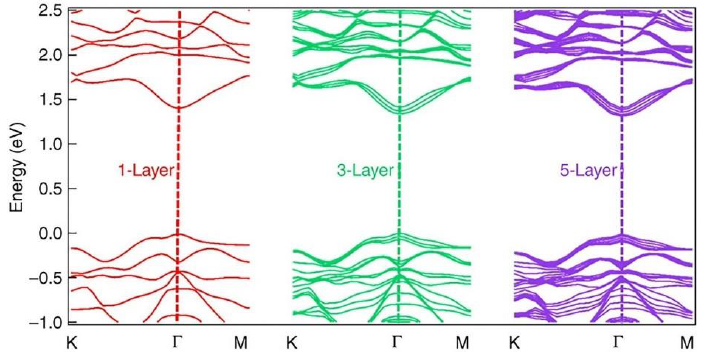
Figure 4. Ab initio calculated electronic band structure of monolayer, trilayer and five-layer ReS 2 indicating band gaps of 1.44, 1.4 and 1.35 eV, respectively. Reprinted under the terms of a Creative